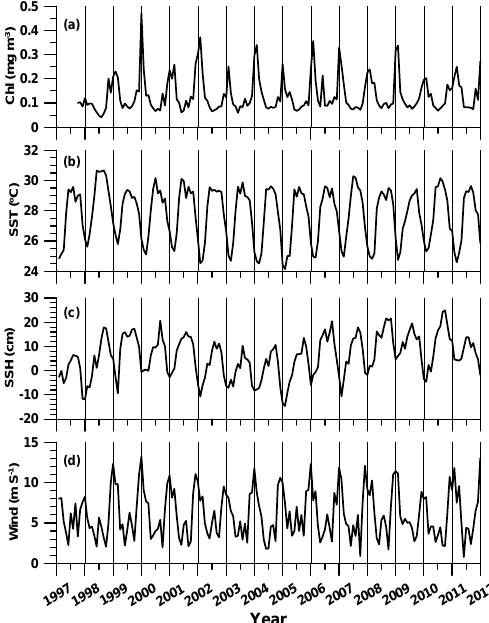
Figure 7. Variations of monthly mean values of environmental variables within the study area: (a) sea surface chlorophyll-a concentration from the merged time-series shown in Fig. 5; (b) sea surface temperature; (c) sea surface height; and (d) wind speed at 10 m above sea level.